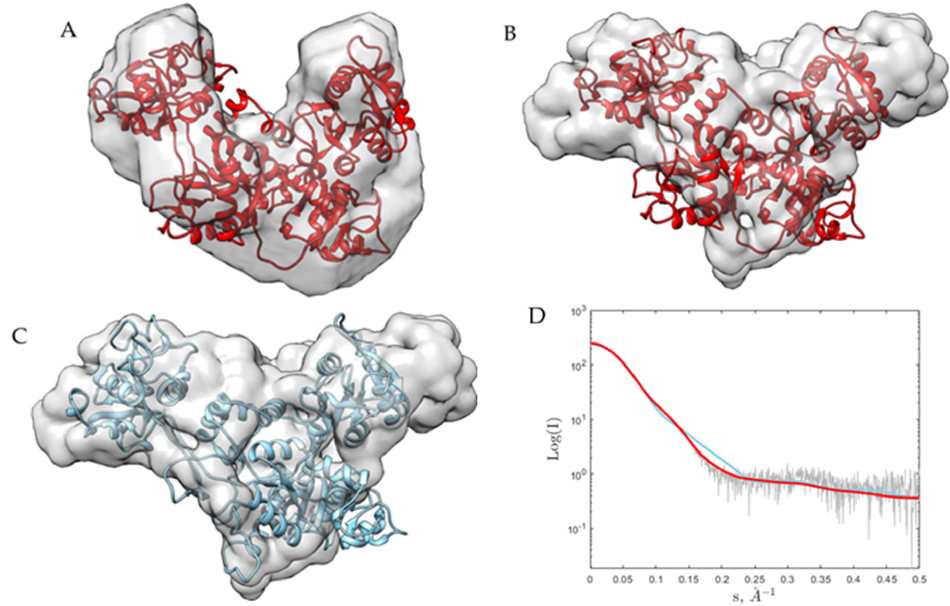
Figure 2. ( A ) and ( B ), 2HAV (chain A) model fit into DAMMIN (ab initio SAXS modeling) for apo-Tf at pH 8.0 and holo-Tf at pH 5.5, respectively. ( C ), 2HAV (chain A) model refined by SREFLEX fit into DAMMIN (ab initio SAXS modeling) for holo-Tf at pH 5.5. ( D ), Fitting of the calculated SAXS for the 2HAV model (chain A) (red) and after the refinement (SREFLEX) (cyan) scattering curves for holo-Tf at pH 5.5 compared to the experimental scattering signal (blue).